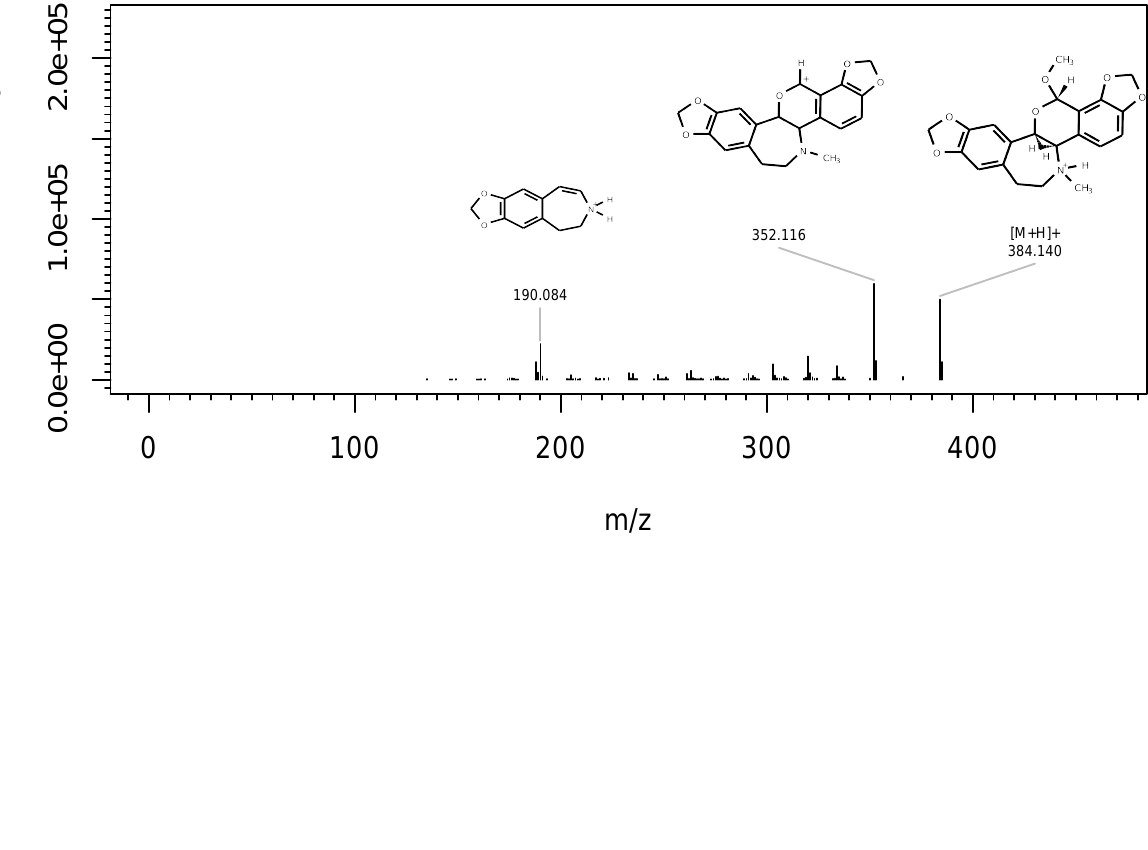
Figure A6. Challenge 6: annotated merged MS/MS spectra of rheadine (ESI, positive